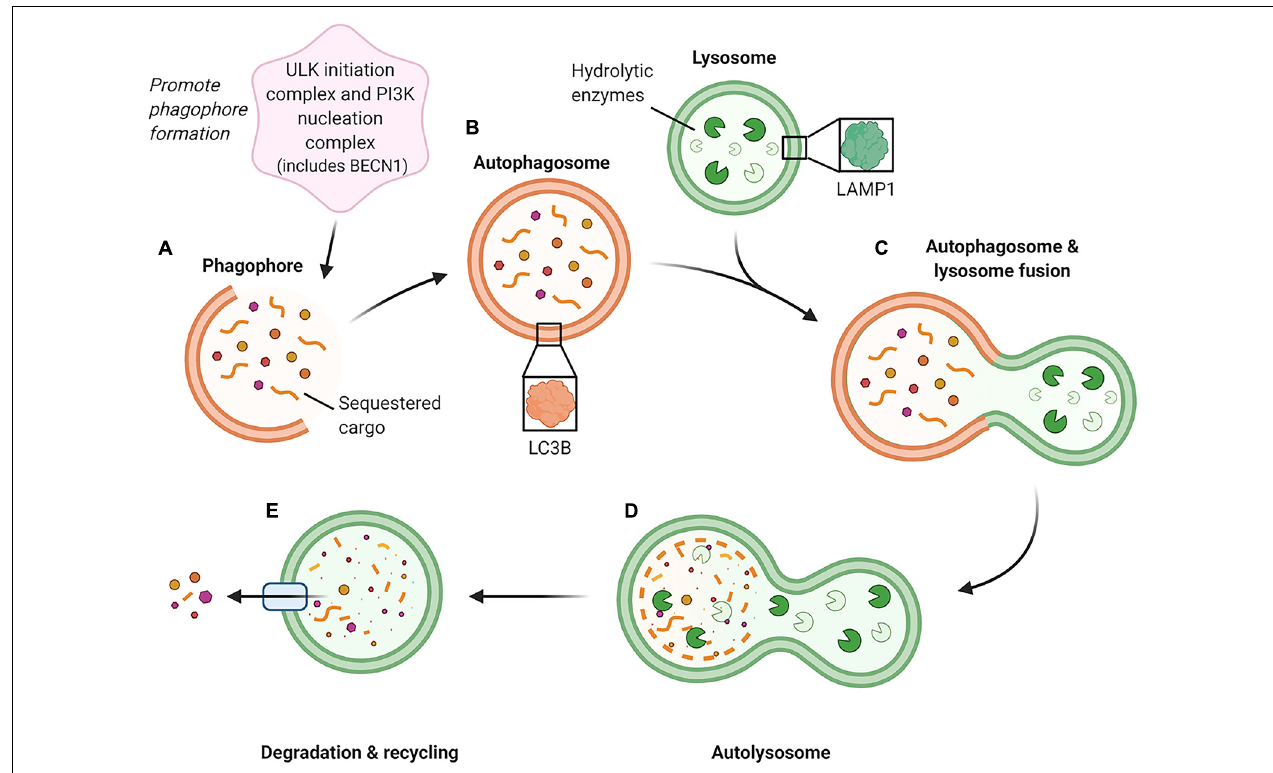
FIGURE 1 | Schematic of the macroautophagy pathway. This pathway is initiated by two groups of proteins, the ULK (unc-51-like kinase 1) initiation complex and the PI3K (phosphoinositide 3-kinase) nucleation complex containing BECN1, which generate the phagophore (immature autophagosome) (A) . As the phagophore continues to grow and sequester cargo, it forms a completed double-membraned vesicle termed the autophagosome, which encompasses the cargo to be degraded (B) . The autophagosome then proceeds to fuse with an acidic lysosome containing hydrolytic enzymes (C) to form an autolysosome. (D) Within the autolysosome, the encapsulated cargo is broken down into its basic building blocks and is then extruded back into the cell cytoplasm for recycling (E) . (Feng et al., 2014; Klionsky et al., 2016) Created with